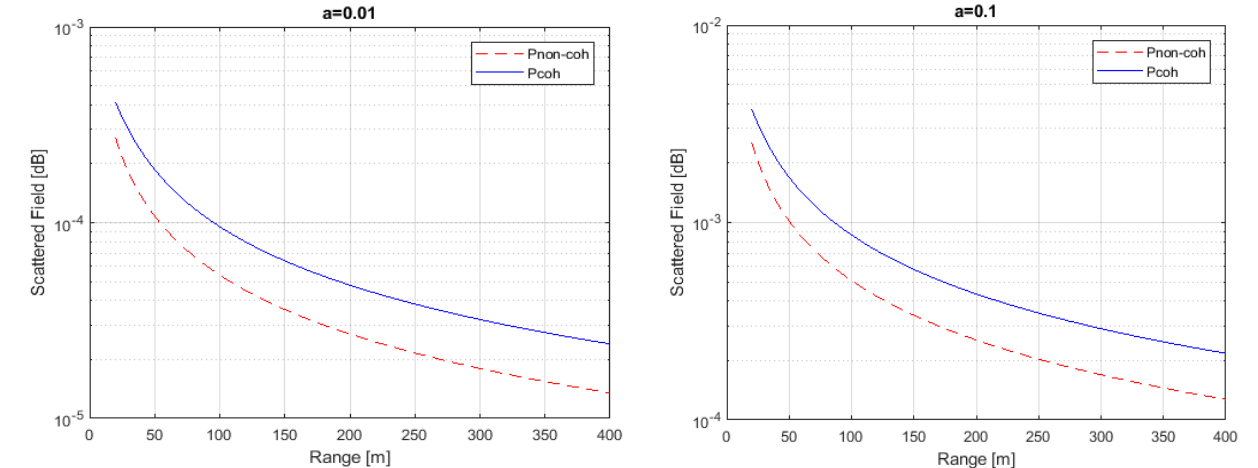
Figure 8. The acoustic scattering fields of a gas bubble with a radius of a = 0.1 cm ( right ) and a = 0.01 cm ( Left ) as a function of range using the proposed coherent method P coh in range migration of SAS system and using the real aperture P non − coh in broadside range.